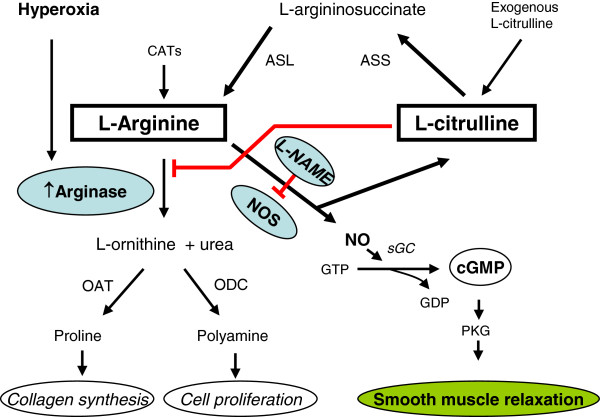
Schematic presentation of the role of L-citrulline/L-arginine cycle in the regulation of airway function. The diagram integrates physiologic, biochemical and molecular mechanisms whereby neonatal hyperoxic exposure impairs NO-cGMP signaling and resultant airway smooth muscle relaxation. The L-arginine is a common substrate for NOS and arginase. Hyperoxia increases the lung arginase activity that reduces the bioavailability of L-arginine to NOS. L-citrulline is recycled to L-arginine through ASS and ASL enzymes. It is proposed that L-citrulline competes with NOS blockers (like L-NAME). However, it blocks arginase activity in hyperoxic conditions and thus increases the bioavailibility of L-arginine. The red lines with bars indicate inhibition. ASS, argininosuccinate synthase; ASL, argininosuccinate lyase; CATs, cationic amino acid transporters; cGMP, cyclic guanosine monophosphate; GDP, guanosine diphosphate; GTP, guanosine triphosphate; L-NAME, Nω-nitro-L-arginine methyl ester; NO, nitric oxide; NOS, nitric oxide synthase; OAT, ornithine amino transferase; ODC, ornithine decarboxylase; PKG, protein kinase G; sGC, soluble guanylate cyclase.